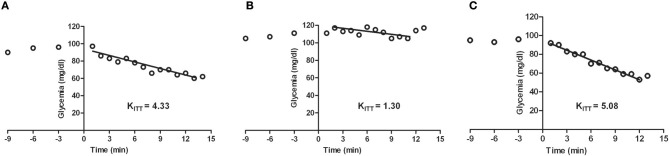
Representative excursion curves for the insulin tolerance test in control (A), high fat (HF) (B), and high fat animals submitted to carotid sinus nerve resection (C) rats. Note that insulin sensitivity, expressed by the constant of the insulin tolerance test (KITT) decrease in the HF animals, this decrease being completely prevented by the bilateral resection of the carotid sinus nerve. HF animals were achieved by submitting the animals to a HF diet (45% lipid-rich diet) during 21 days. Bilateral resection of the carotid sinus nerve (C) was performed 5 days prior to submitting the animals to HF diet (adapted from Ribeiro et al., 2013).